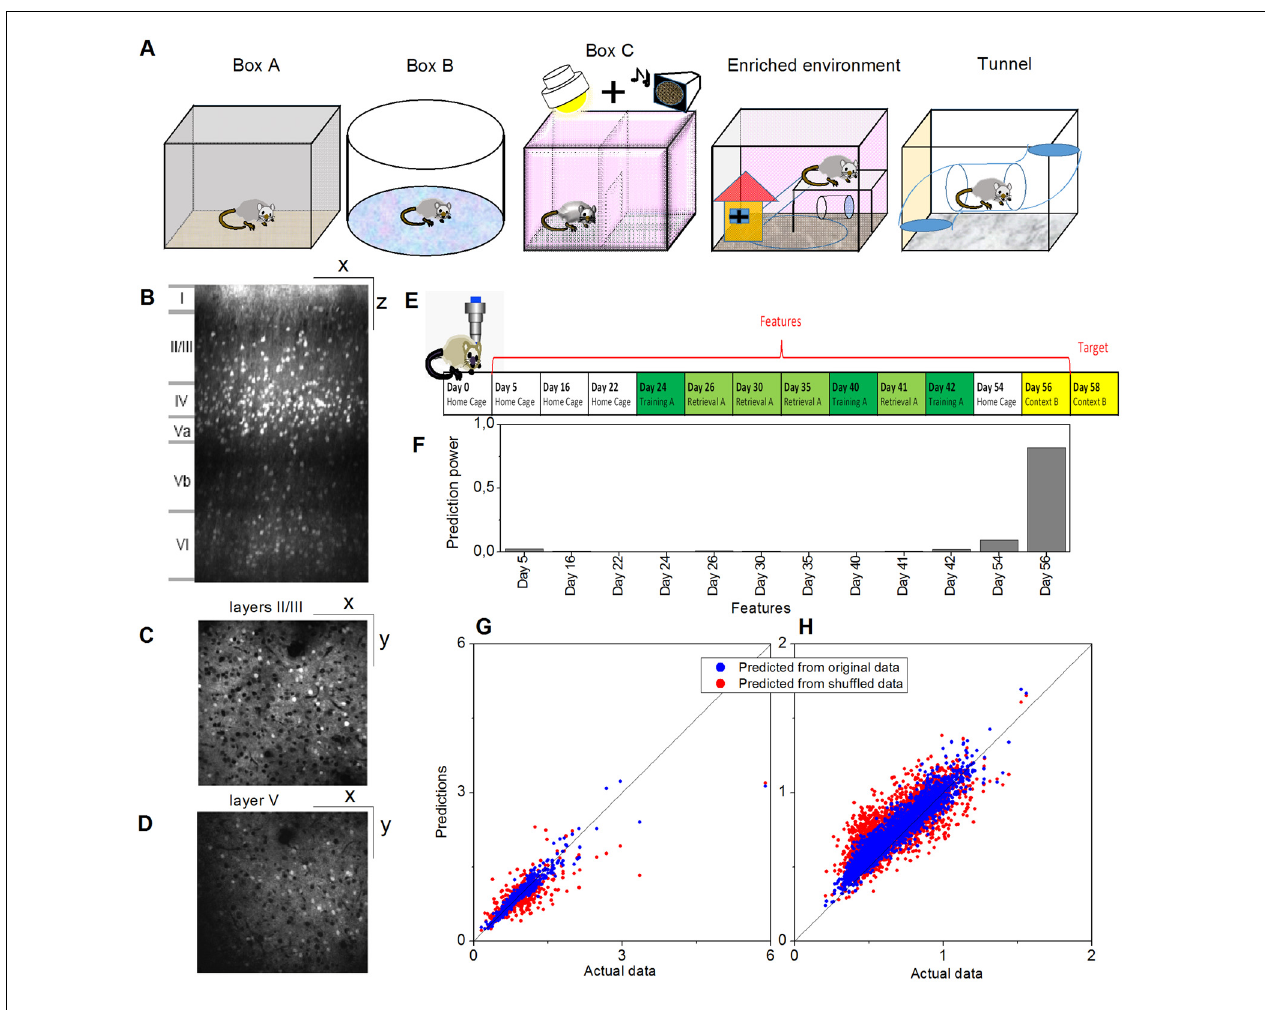
FIGURE 1 | Example of a prediction of memory trace activities. (A) Illustration of different environments employed in this article. (B) One example slice of cortical location A1 (primary visual, VISp, left) of animal Ma and the manual annotations of the cortical layers, where x indicates the anterior-posterior direction and z indicates the superior-inferior direction. Panels (C,D) show slice examples of layers II/III and layer V (more specifically, Vb) of the same cortical location A1, where x indicates the anterior-posterior direction and y indicates the rostrocaudal direction. (E) The model was trained on layers II/III in this cortical location A1. Neural activities on Day 58 (context B) were used as the target, and the data for 12 previous days were used as the features. (F) Prediction powers of the 12 days in features. (G) Prediction performance of the model on other layers II/III neurons within the same location, and (H) prediction performance of the same model on all layer V neurons within the same location, where blue dots indicated the prediction from the original data [ R 2 = 0.82 in panel (G) and R 2 = 0.81 in panel (H) ] and red dots from the shuffled data [ R 2 = 0.61 in panel (G) and R 2 = 0.48 in panel (H)